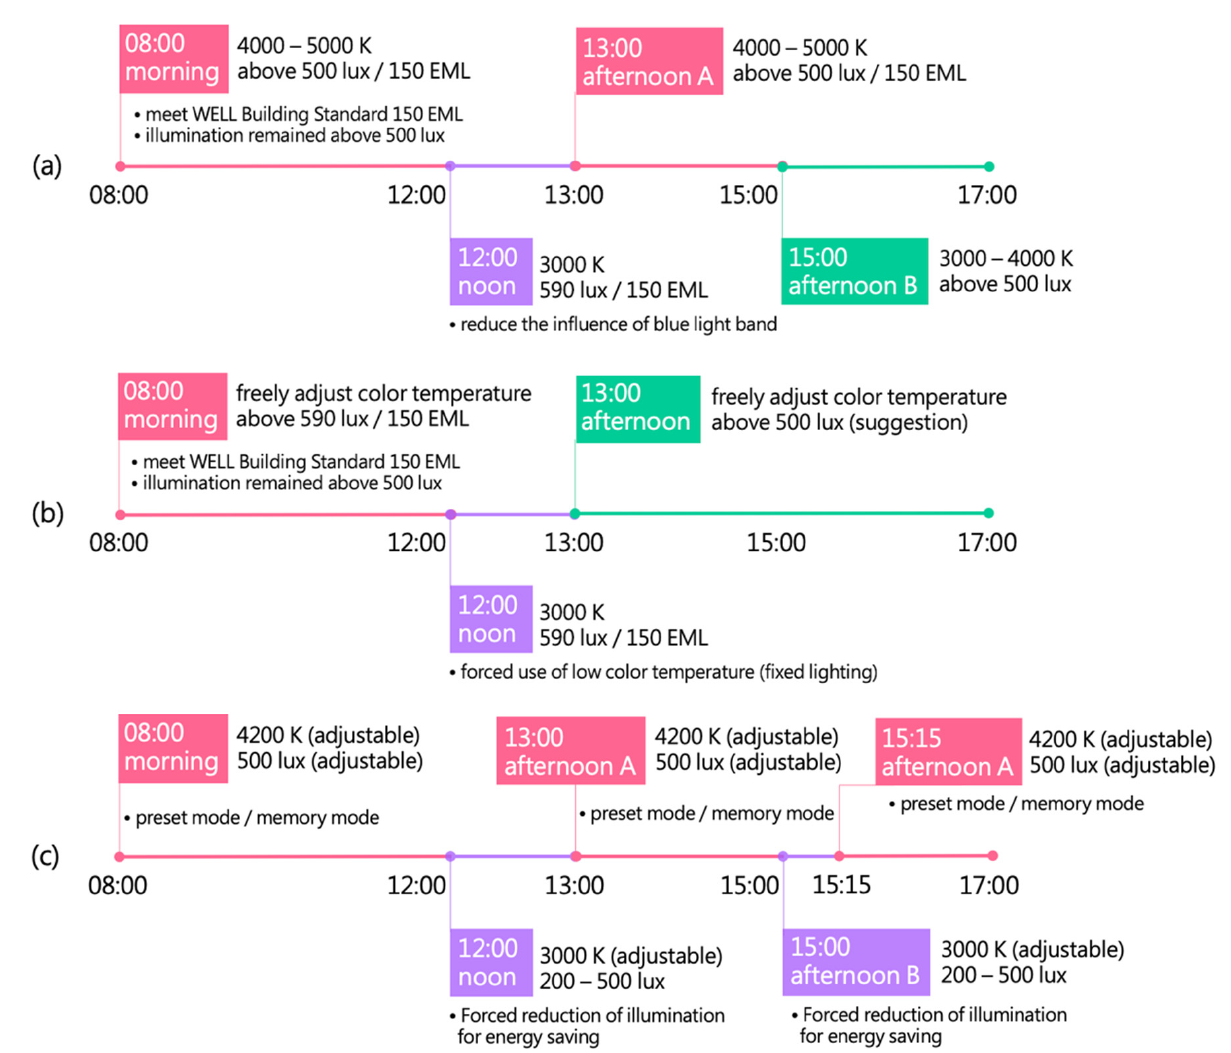
Figure 9. Comprehensive lighting control strategies: ( a ) Fixed lighting control strategy based on productivity and circadian rhythm; ( b ) Adjustable lighting control strategy based on productivity and circadian rhythm; ( c ) Adjustable lighting control strategy based on psychology and energy- saving.